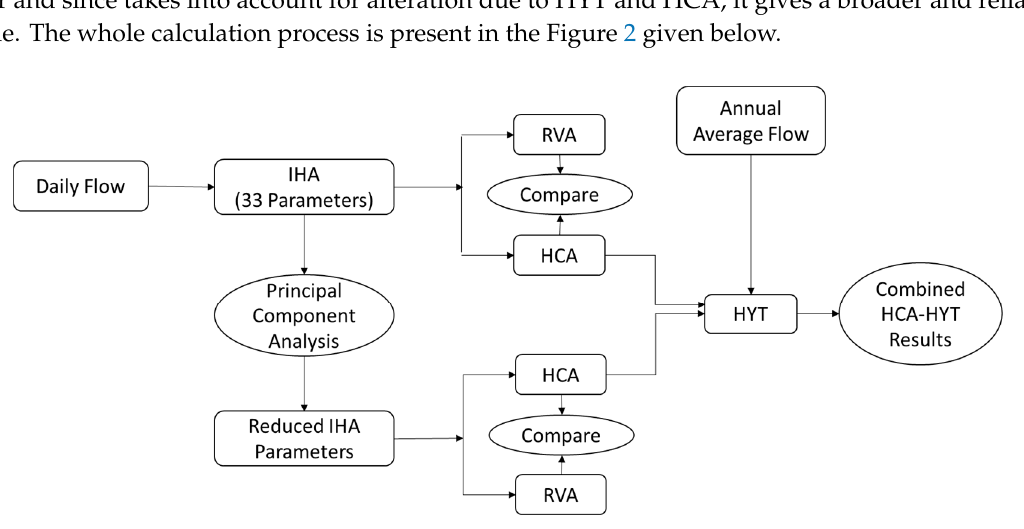
Figure 2. Schematic layout of the calculation methodology.